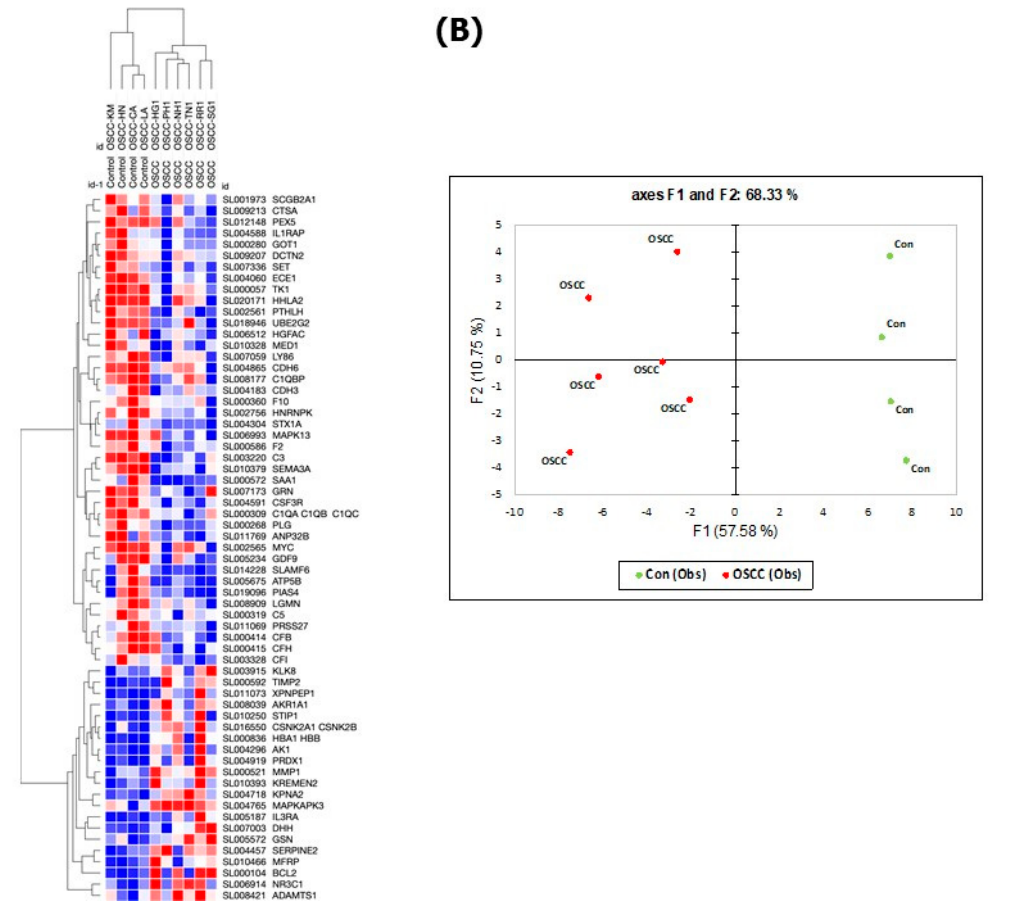
Figure 1. Hierarchical clustering ( A ) and Principal Component Analysis ( B ) of 63 OSCC-associated proteins that accurately discriminate between preoperative OSCC ( left column) and healthy controls ( right column, p < 0.05). Red = up-regulated, blue: down-regulated. To identify the signaling pathways and biological mechanisms enriched signi fi cantly by the OSCC-associated proteins, we next performed an Ingenuity Pathway Analysis (IPA) using as the input the 63 OSCC-associated proteins. The IPA for bio functions converged on the enrichment of proteins associated with cell death (necrosis, necrosis of epithelial tissue, apoptosis, apoptosis of epithelial cells and cell death of epithelial cells), migration of immune cells (leukocyte migration, cell movement of leukocytes, cell movement of phagocytes, cell movement of neutrophils and cell movement of myeloid cells), anemia, proteolysis, neovascularization and cytolysis (Figure 2A). A total of 41 proteins were